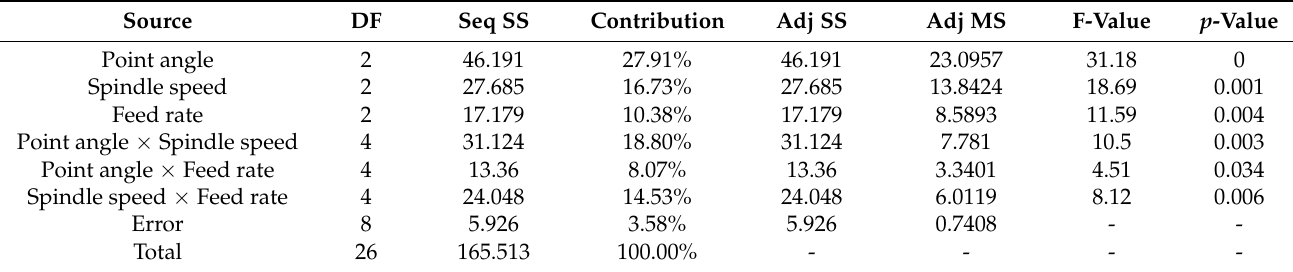
Figure 7. The morphology of a drilled hole in the composite structures. ( a ) Matrix failure, ( b ) Micro cracks, ( c ) Matrix smearing, ( d ) Fibre protrusion, ( e ) Uncut fibres. Table 6. ANOVA results of surface roughness